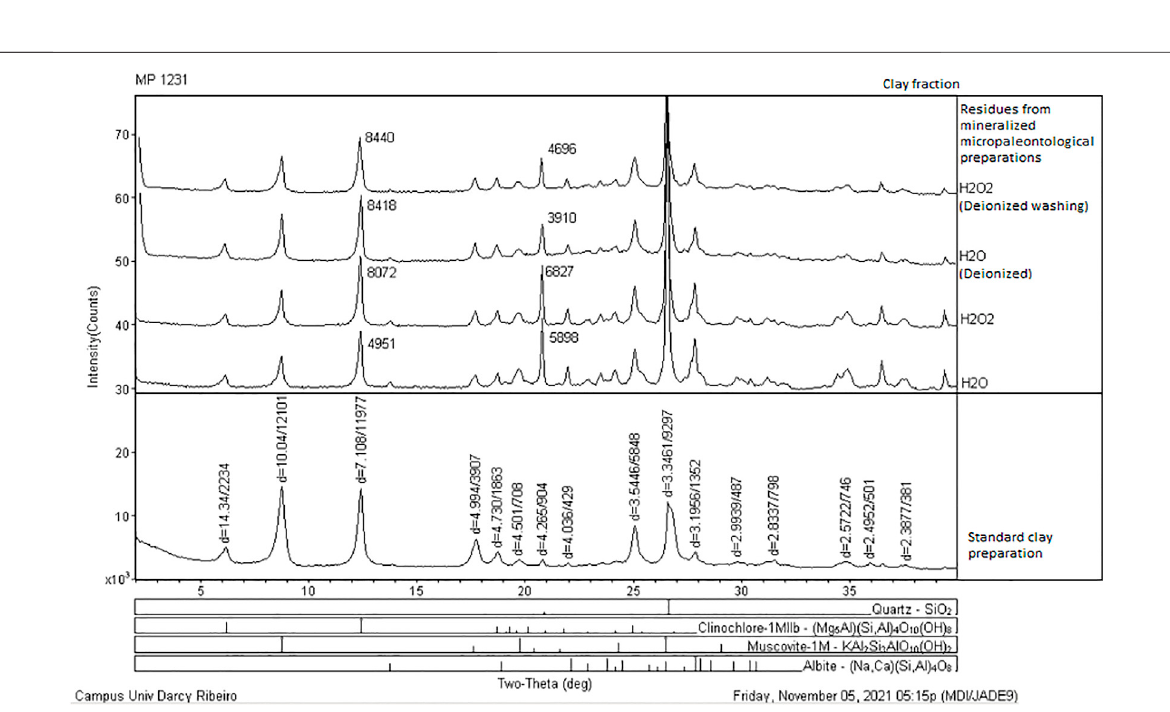
Frontiers in Earth Science |